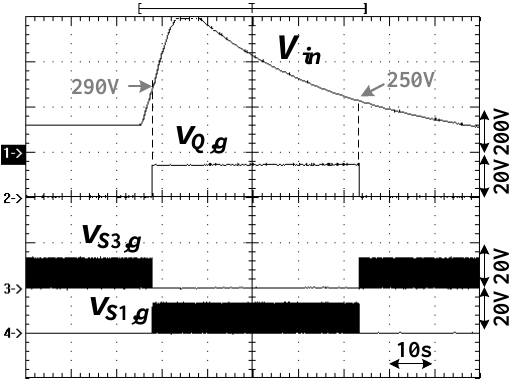
Figure 14. Test waveforms of V in , v Q,g , v S 1 ,g , and v S 3 ,d under V in = 120 – 600 V variation.